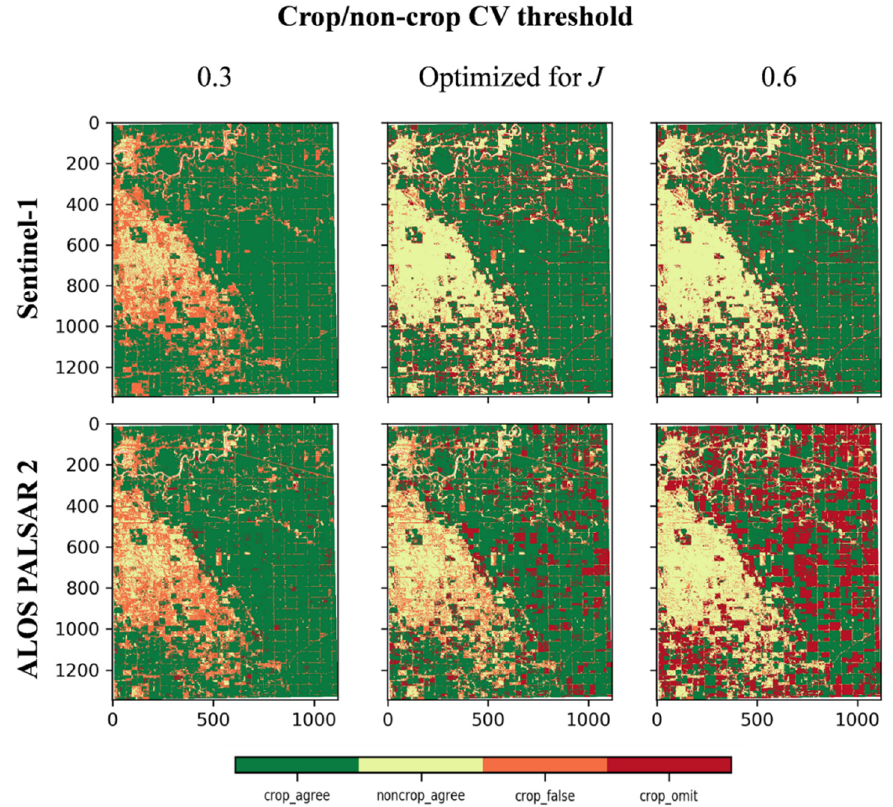
Figure 4. Crop/non-crop confusion matrix results for classifications based on Sentinel-1 and PALSAR-2 data (columns) as a function of crop delineating threshold (CV thr , rows) shows high rates of crop area omission in the longer L-band PALSAR-2 data at higher thresholds.